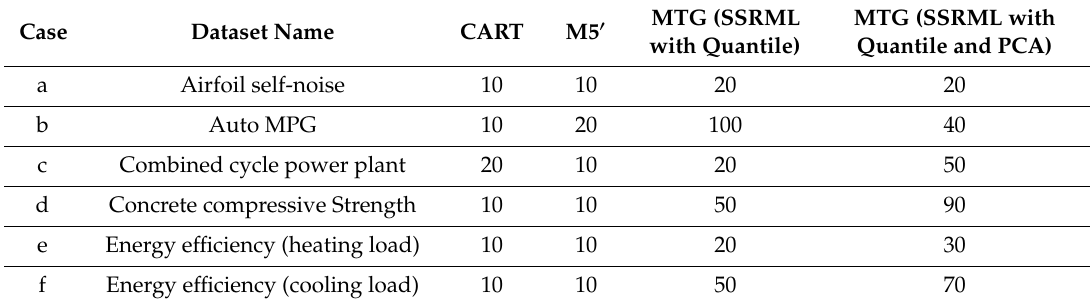
Table 2. Minimum leaf size value for each case study and algorithm.